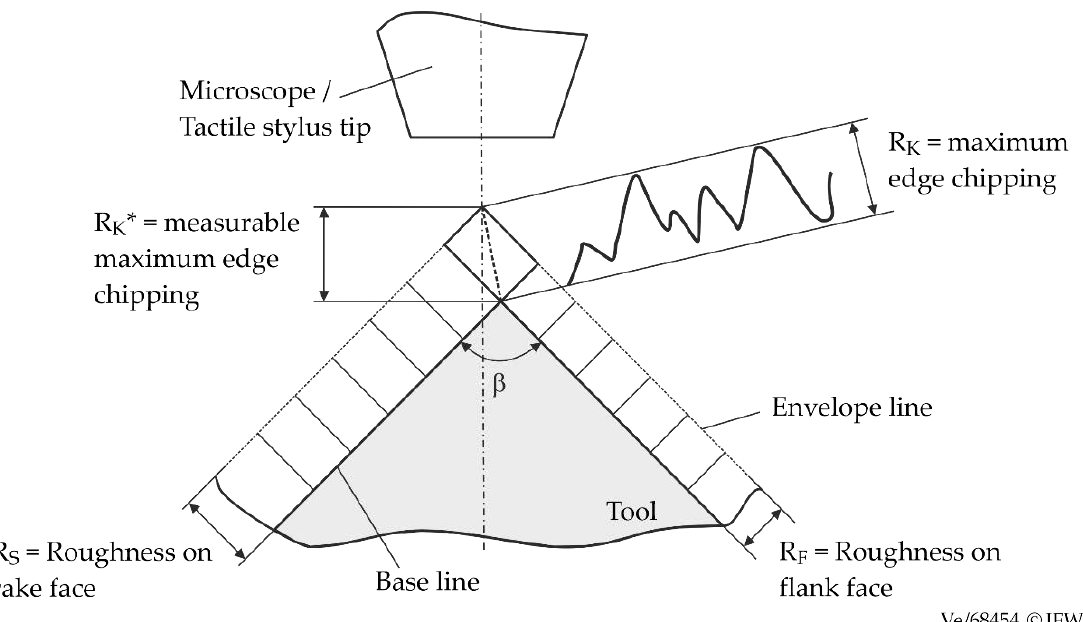
Figure 1. Schematic representation of cutting edge chipping.